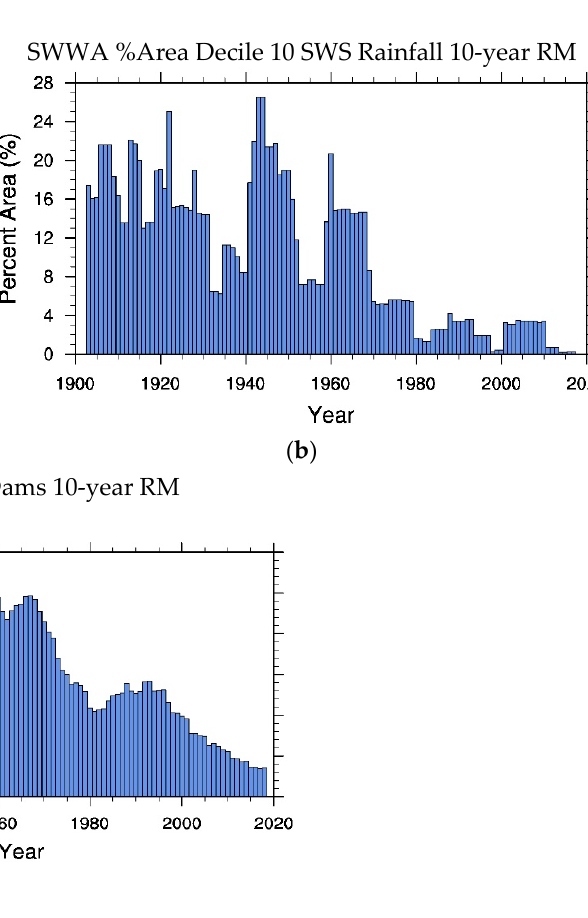
8 of 27 Table 3. The average gradients or trends of 10-year RM of SWWA rainfall in SWS, January to De- cember streamflow into Perth dams and percentage area of SWWA with SWS rainfall in decile 10 (PAR D10 ) for different time periods.